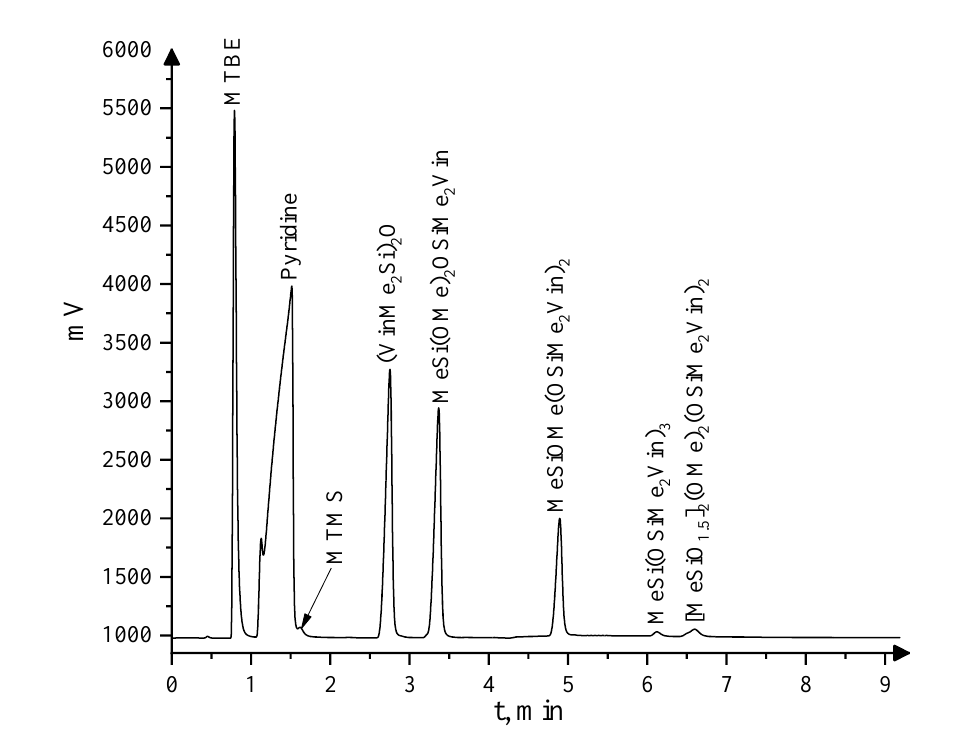
Figure 5. GLC curve for the fraction of Sample 5 (Table 1) with T b ≤ 85 ◦ C/1 Torr. The oligomeric fraction is a mixture of highly functional soluble oligomers with a methylsilsesquioxane structure according to 1 H NMR spectroscopy and GPC (Table 1).